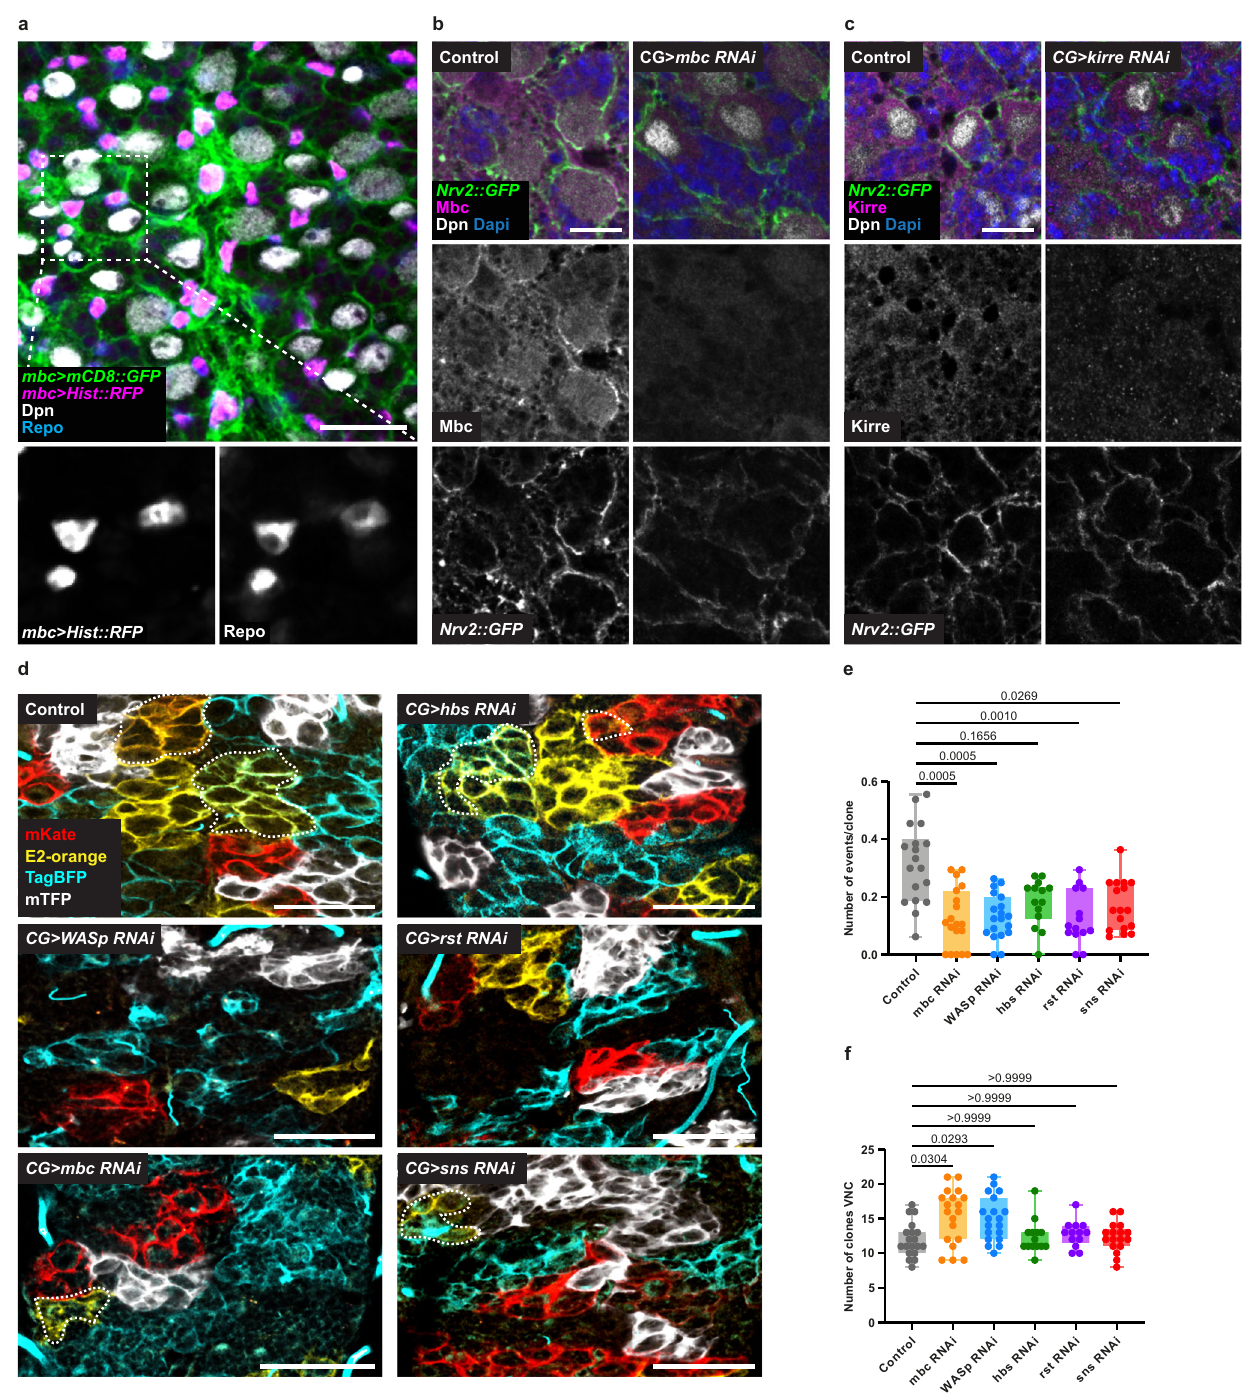
Fig.8|CellfusionbetweenCGunitsisregulatedbycanonicalfusionmolecules. a Expression of membrane targeted GFP ( mCD8::GFP , green) and nuclear RFP ( Hist::RFP , magenta)using the trojanline mbc-Gal4 to assess the expression of mbc in CG. Glia nuclei were labelled with Repo (blue) and NSC were labelled with Dpn (grey). Scale bar: 20 μ m. b Endogenous expression of Mbc in the CNS assessed by immunostaining with Mbc antibody (magenta) in the VNC. CG membranes are labelled with Nvr2::GFP (green), NSC are labelled with Dpn (grey) and Dapi (blue) was used to visualise all nuclei. Left panels show the expression in control CNS. Right panels show the expression after RNAi knockdown of mbc . Scale bar: 10 μ m. c Endogenous expression of Kirre in the CNS assessed by immunostaining with Kirre antibody (magenta) in the VNC. CG membranes are labelled with Nvr2::GFP (green), NSC are labelled with Dpn (grey) and Dapi (blue) was used to visualise all nuclei. Left panels show the expression in control CNS. Right panels show the